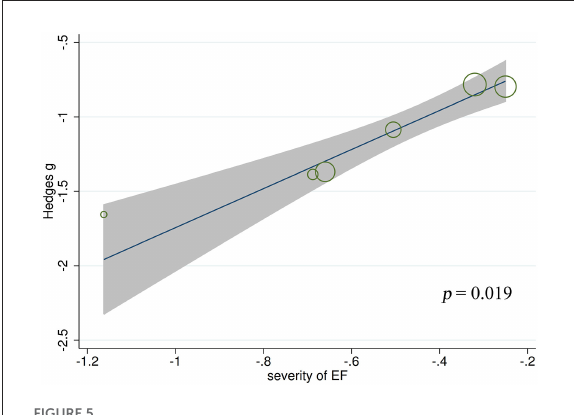
FIGURE5 Associations between aggregated effect sizes of the studies investigating ToM performance and severity of EF. ToM, theory of mind; EF, executive